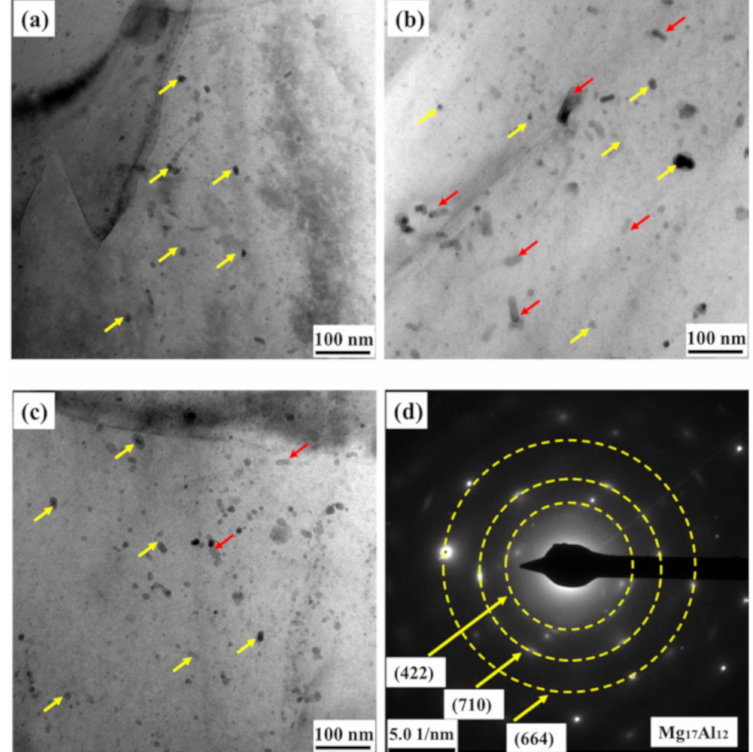
Figure 11. TEM micrographs of the precipitates in ( a ) 623 K-4P, ( b ) 623 K-12P, and ( c )573 K-12P alloys, as well as ( d ) the corresponding SAED patterns of the